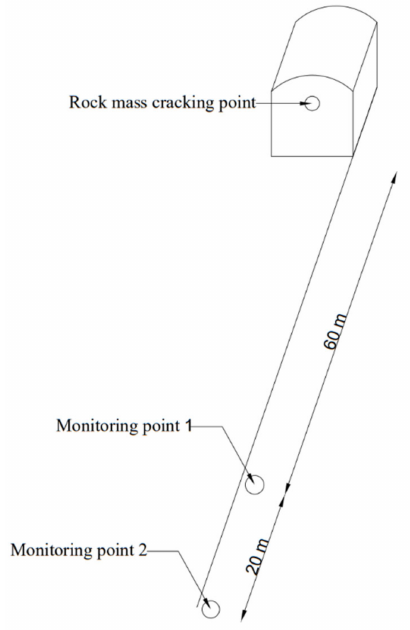
Figure 15. Arrangement of monitoring. points.